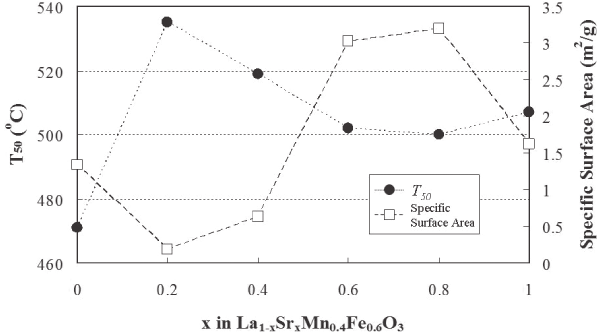
Fig. 4: Result of soot combustion experiment and BET measurement of prepared La Sr Mn Fe O . X axis shows the amount of Sr in 1 − x x 0.4 0.6 3 La Sr Mn Fe O and Y axis shows T ; the temperature at which 1 − x x 0.4 0.6 3 50 50% of the soot has been oxidized ( ● ), and specific surface area ( □